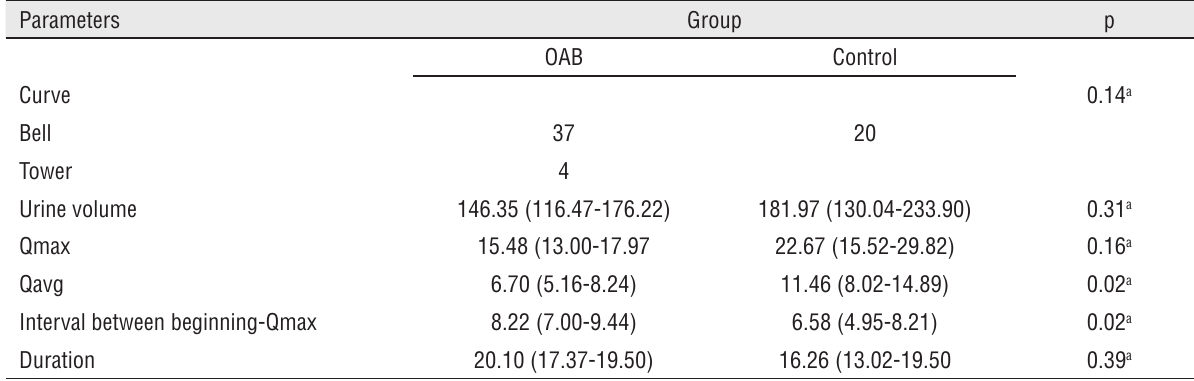
Table 2 - Characteristics of uroflowmetry.